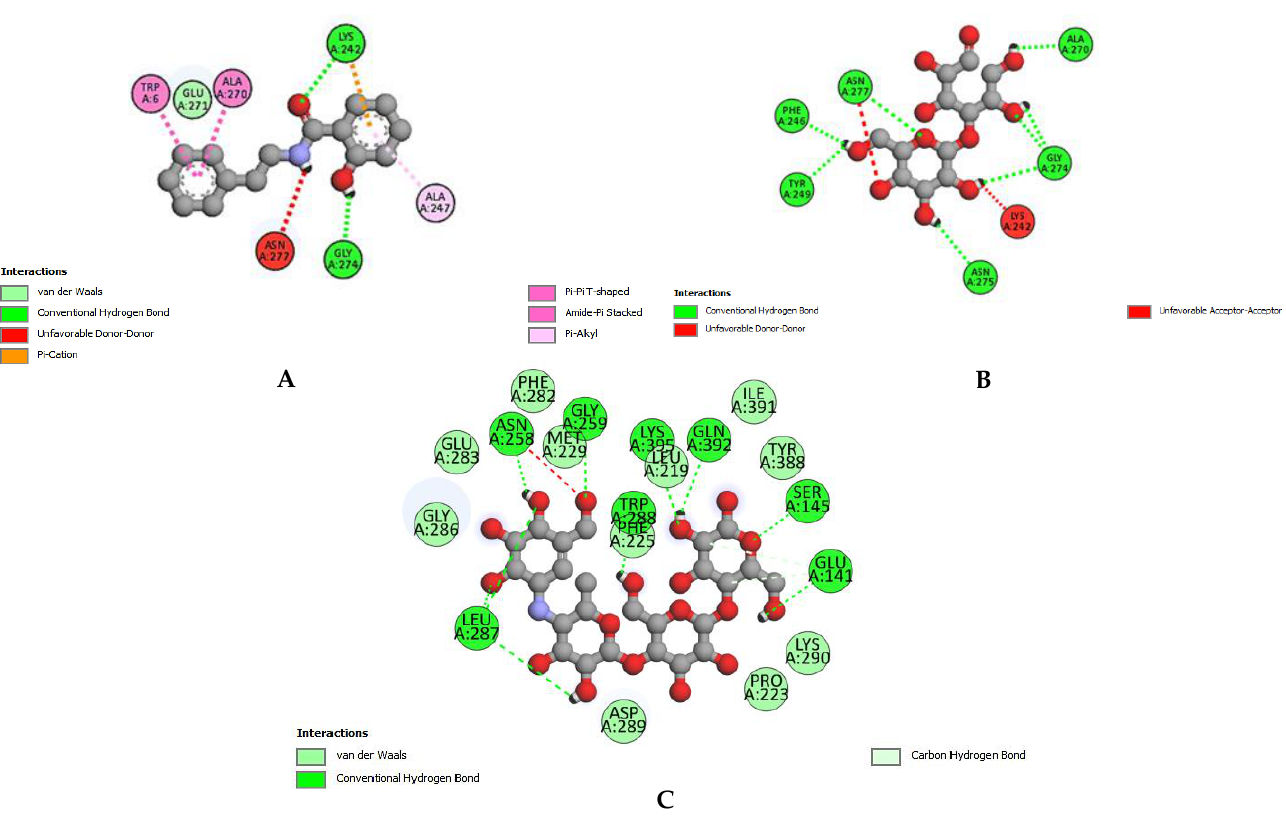
Figure 1. Interaction between α -glucosidase and ligands. ( A ) 2-hydroxy-n-(2-phenylethyl) benzamide, ( B ) lactose, and ( C ) Acarbose.